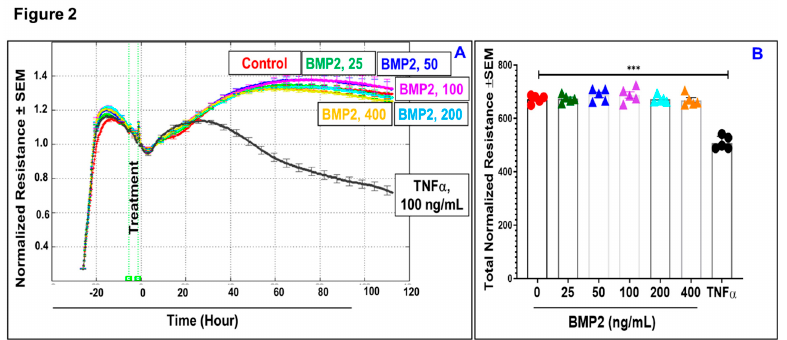
Figure 2. Normalized resistances of BMP2-treated ARPE-19 cells measured at a frequency of 4000Hz by electrical cell-substrate impedance sensing (ECIS) ( A ), and the statistical analysis ( B ). Our experiments were carried out after ARPE-19 cells formed confluent mature monolayers indicated by a plateau of electronic resistance, where the resistance reached 1000 ohms. However, to monitor changes in the resistance in real time, the data are presented as normalized TER resistance calculated by dividing the resistance of each well measured in ohms at each time point by the baseline resistance (ohms) acquired before the addition of the BMP2 and plotted as a function of time. There was no significant drop in the resistances of ARPE-19 cells with direct BMP2-treatment in the range of (0–400 ng / mL) over the experimental period as compared to positive control of TNF- α treated ARPE-19 cells. Red circles: control; green triangles: BMP2 (25 ng / mL); blue triangles: BMP2 (50 ng / mL); purple triangles: BMP2 (100 ng / mL); aqua triangles: BMP2 (200 ng / mL); orange triangles: BMP2 (400 ng / mL); black circles: TNF α (100ng / mL). Results are presented as mean ± SEM, n = 4–6; *** = P <